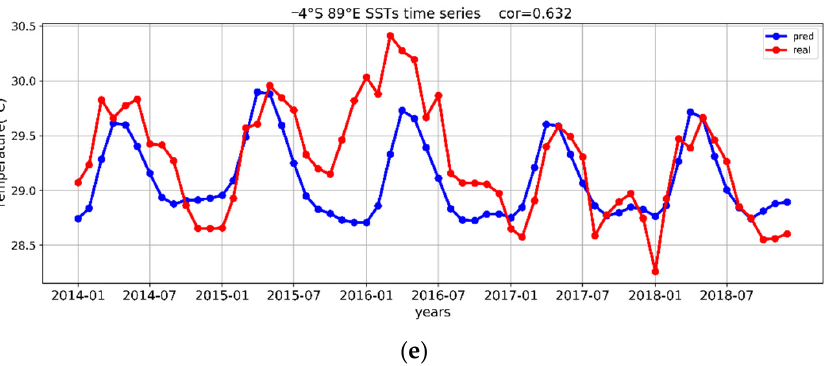
Figure 4. The changes in the observed SSTs and the predicted SSTs in the period from 2014 to 2018 are reflected by five data points that were randomly selected from five correlation ranges. ( a – e ) take the five years SST curve of points with correlation of 60–100%.